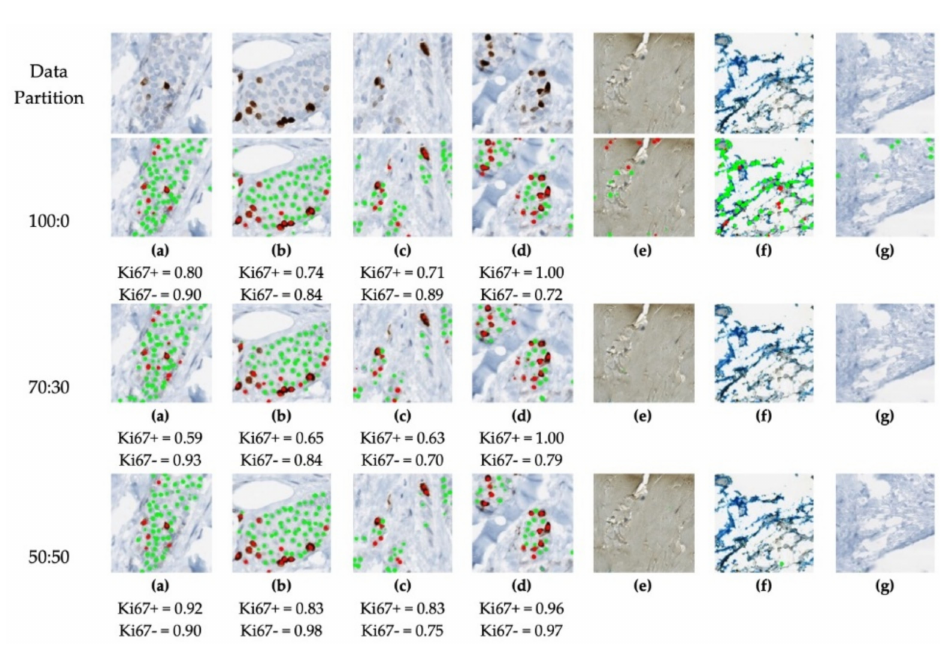
Figure 11. Nuclei detection performance of piNET trained using different amounts of nonideal patches of data. ( a – d ) images contain tumor nuclei and ( e – g ) contain background regions with no tumor nuclei. Green annotations correspond to hematoxylin labels and red to Ki67+